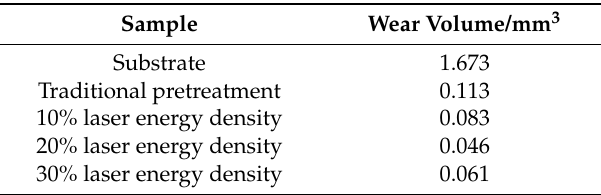
Table 3. Substrate and coatings wear volume.